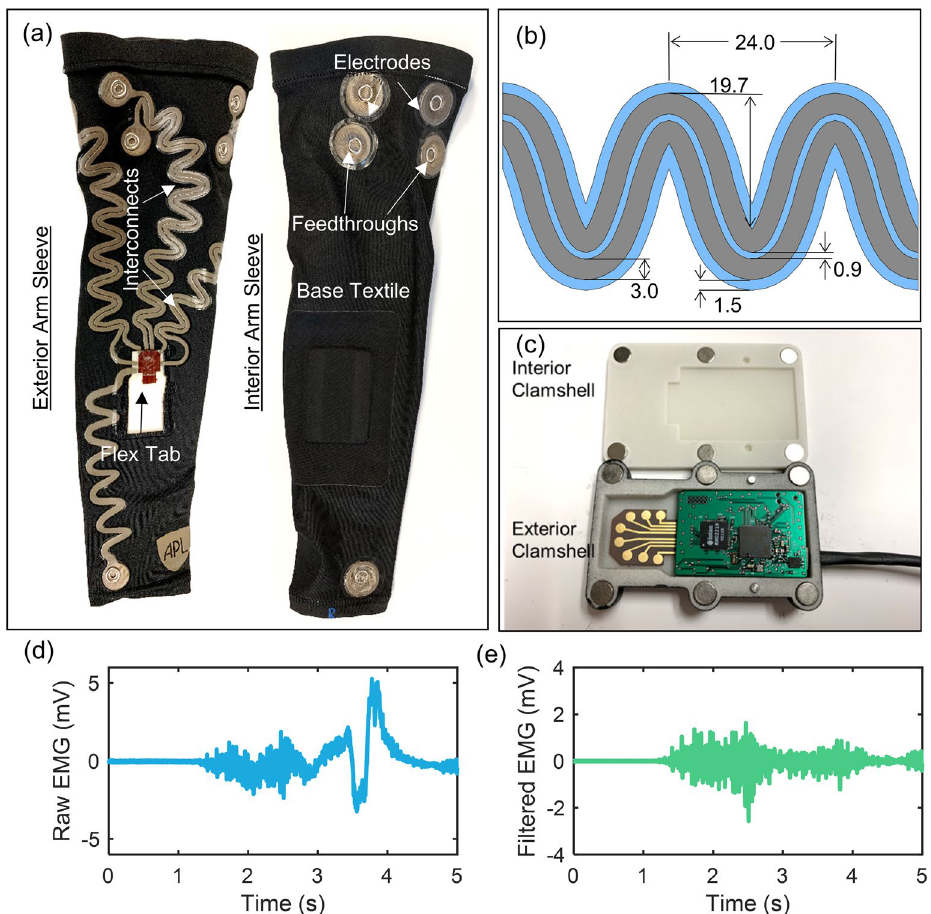
Figure 6. Finalized arm sleeve design showing the ( a ) labeled image of the interior and exterior of the sleeve, ( b ) schematic of tall nested interconnect design showing e-textile (gray/dark) and protective TPU (blue/light, dimensions in mm), and ( c ) image of the flex tab in the optional custom built glass filled nylon enclosure. Exemplar elbow flexion EMG plot from the arm sleeve showing ( d ) raw data and ( e ) filtered